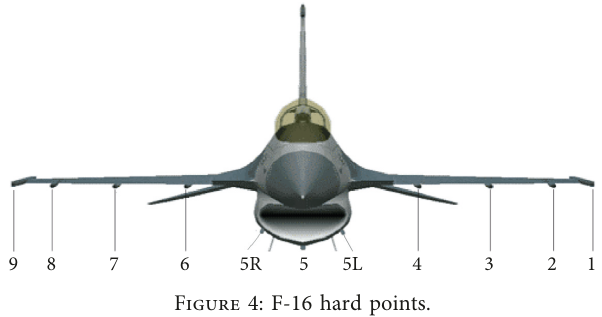
Figure 4: F-16 hard points. Table 2: Configurations for model updating. Station